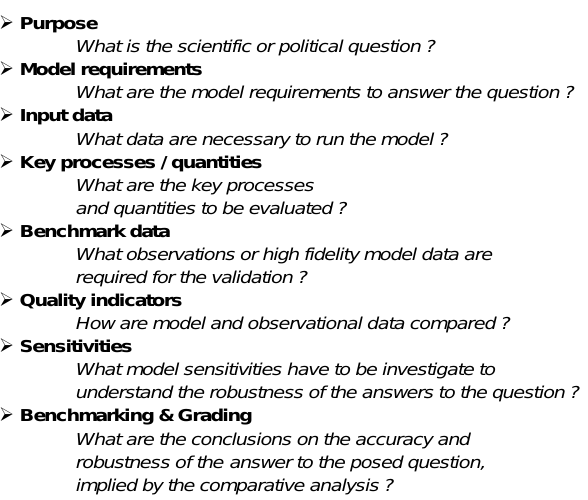
Fig. 1. Overview on the ACCENT model evaluation